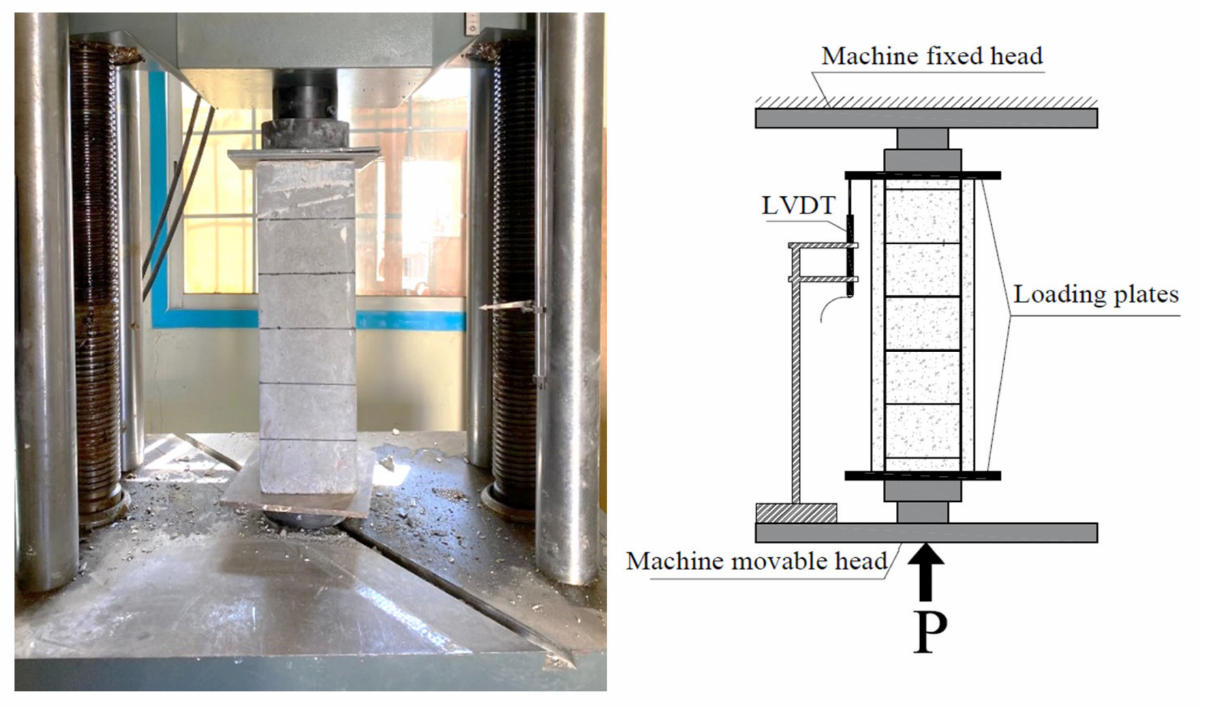
Figure 6. Testing of concrete columns under compression loading.